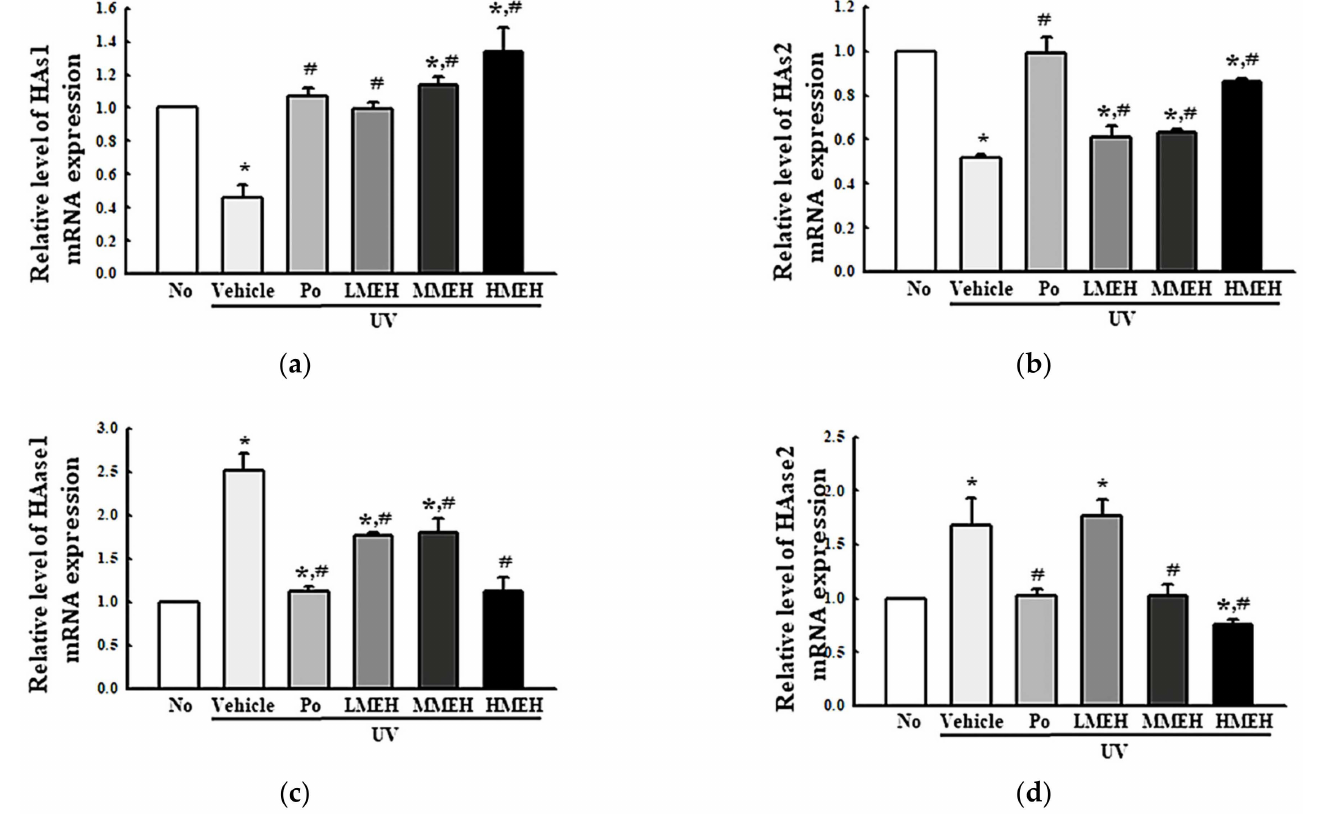
Figure 8. Expression of the ECM components in normal human dermal fibroblasts. The expression levels of HAs ( a , b ) and HAase ( c , d ) mRNA were measured in the total RNA prepared from three dishes per group after treatment of each concentration of MEH. RT-qPCR analysis was performed in triplicate. This experiment was performed for three times and results are the average of all experiments. The data are reported as the means ± SD of triplicate determinations. * p < 0.05 com- pared to the untreated group. # p < 0.05 compared to the UV + Vehicle group. Abbreviations: